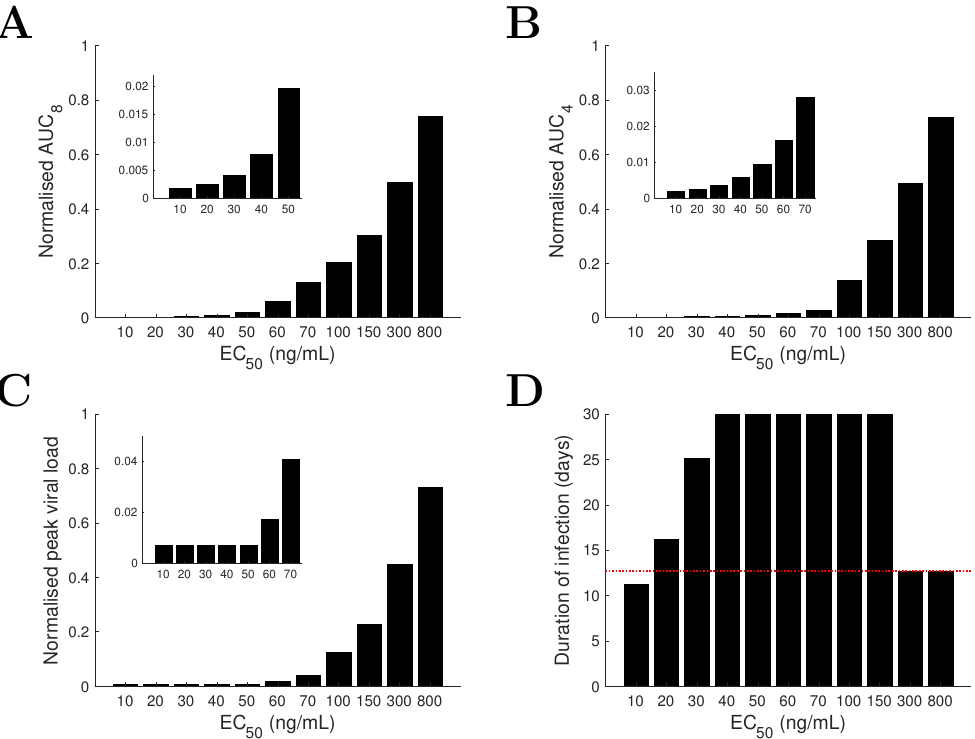
Figure 5. Dependence of infection-related quantities on drug efficacy for the TIV model. As drug efficacy EC 50 varies from 10 ng/mL to 800 ng/mL, infection-related quantities, under the curve (AUC) ( A , B ), peak viral load ( C ) and duration of infection ( D ), are shown in different panels. AUC 8 , AUC 4 and peak viral load are normalised to their corresponding quantities in the no-drug control. Insets show sub-parts of the plots. For duration of infection longer than 30 days, we truncate the duration at 30 days in panel D . The duration of infection without antiviral treatment is indicated by the dotted red line in panel D